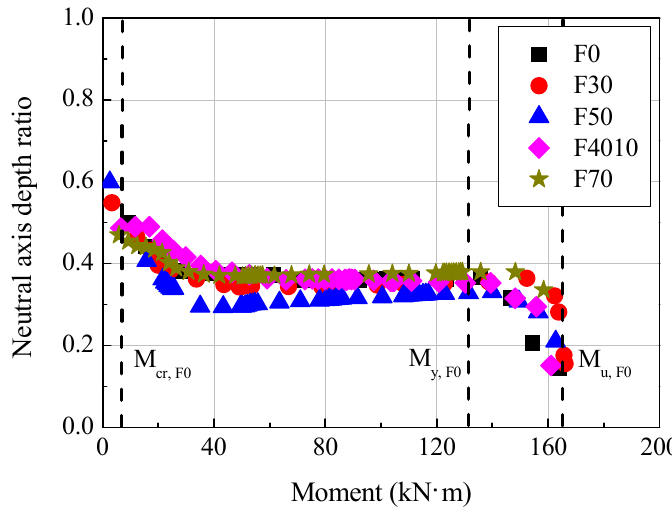
Figure 7. Neutral axis depth ratio-moment relationships of F series.